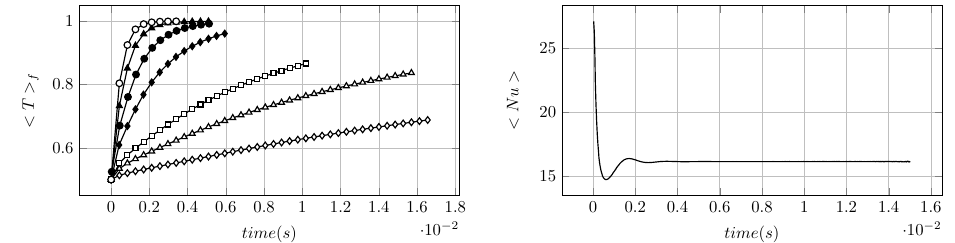
Figure 9. Left : Time evolution of fluid temperature for a uniform flow past a Face-Centered Cubic array of spheres at Re = 50 and ( ) α d = 0.05, ( ) α d = 0.1, ( ) α d = 0.15, ( ) α d = 0.3, ( ) α d = 0.4, ( ) α d = 0.5, ( ) α d = 0.6. Right : Time evolution of the averaged Nusselt coefficient for a uniform flow past a Face-Centered Cubic array of spheres at Re = 50 and α d = 0.4.